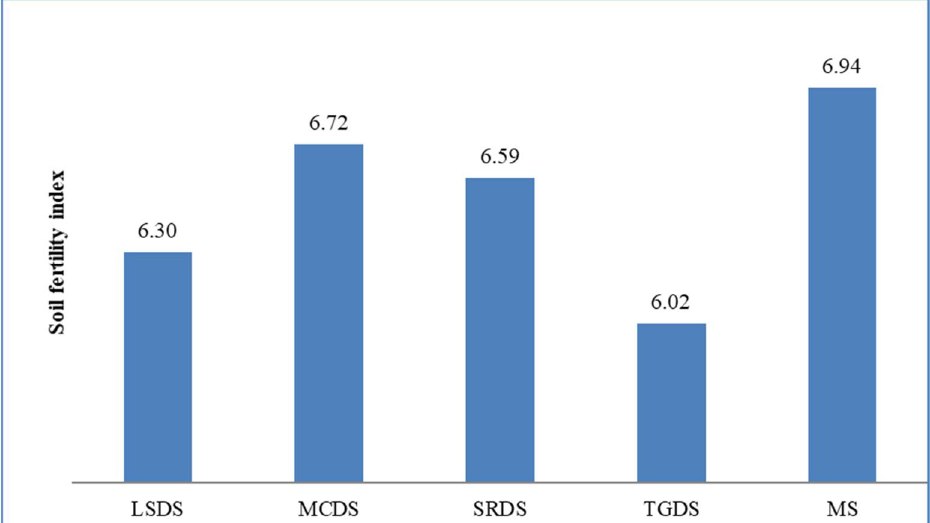
Figure 3. Soil fertility indices of the stands irrespective of soil depth.